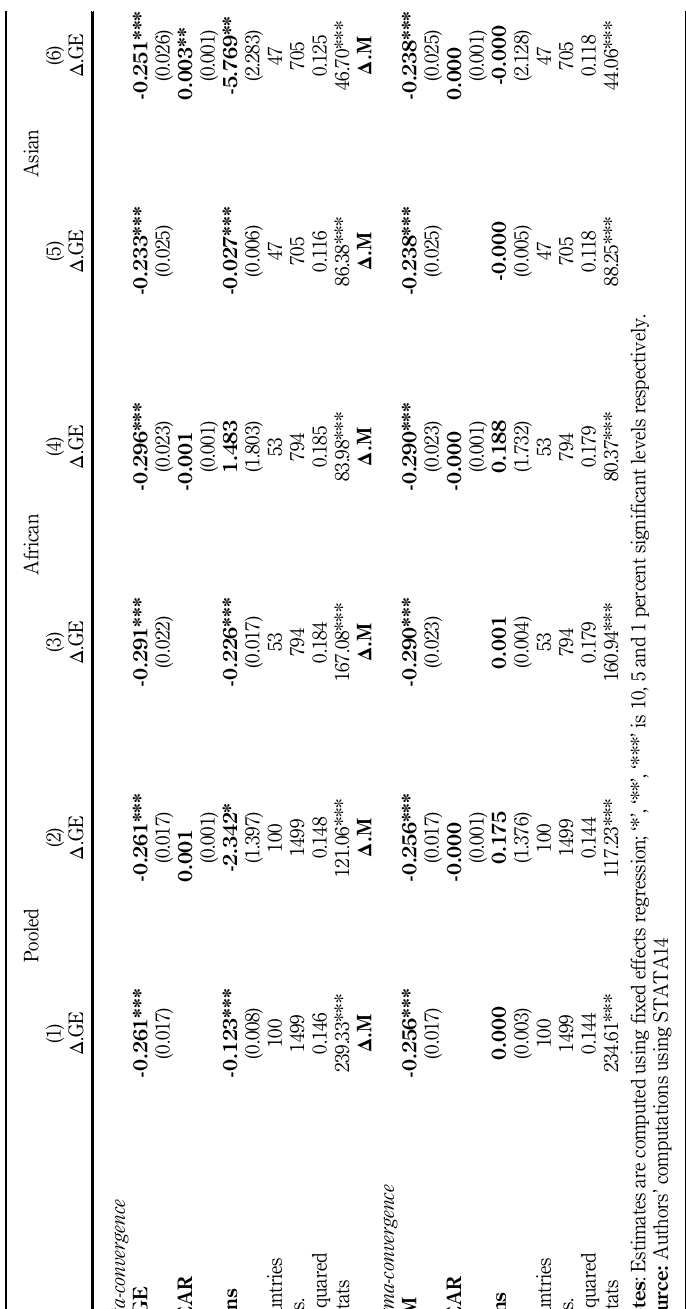
Table 5. The convergence of government effectiveness in Africa and